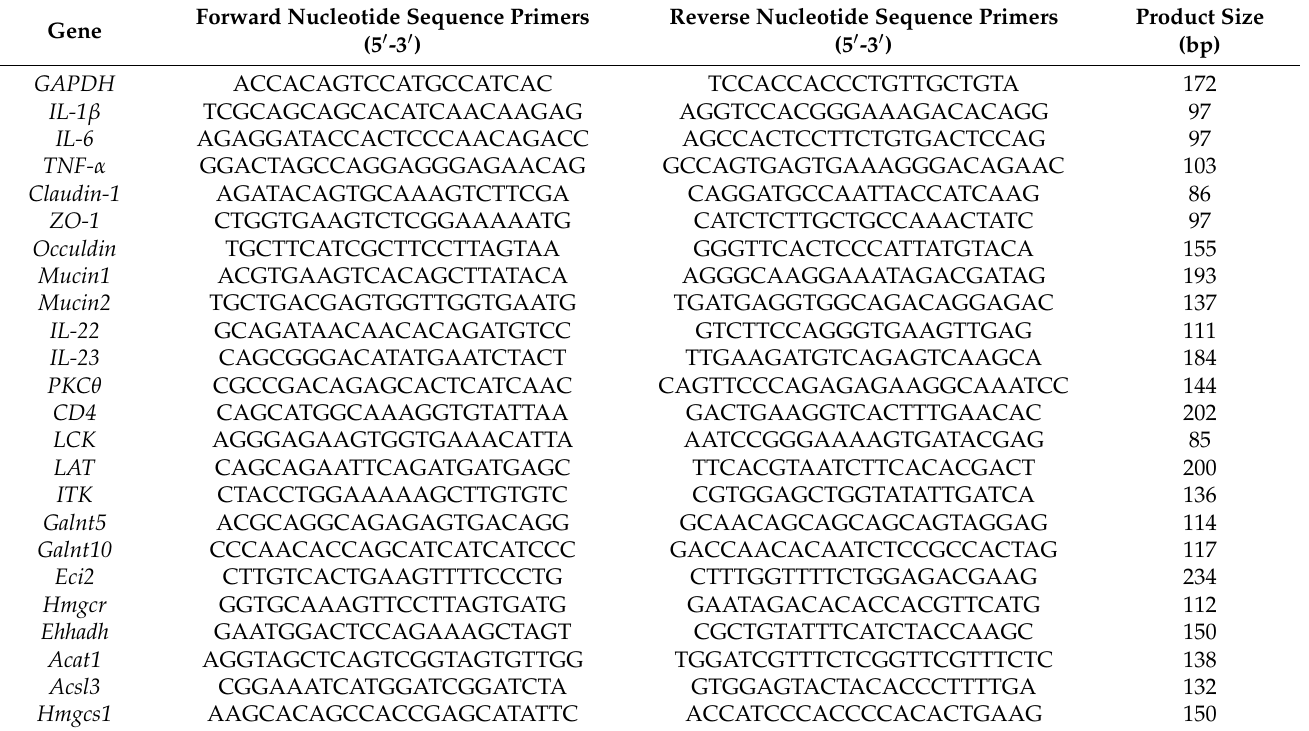
Table 1. Primers Used for qRT-PCR